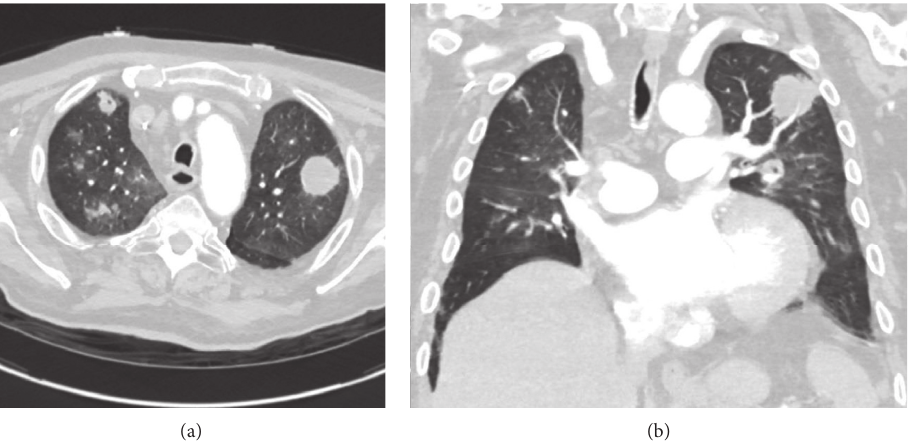
Figure 3: (a, b) Chest CT: invasive pulmonary aspergillosis. Chest CT findings, 2 months after initial presentation.